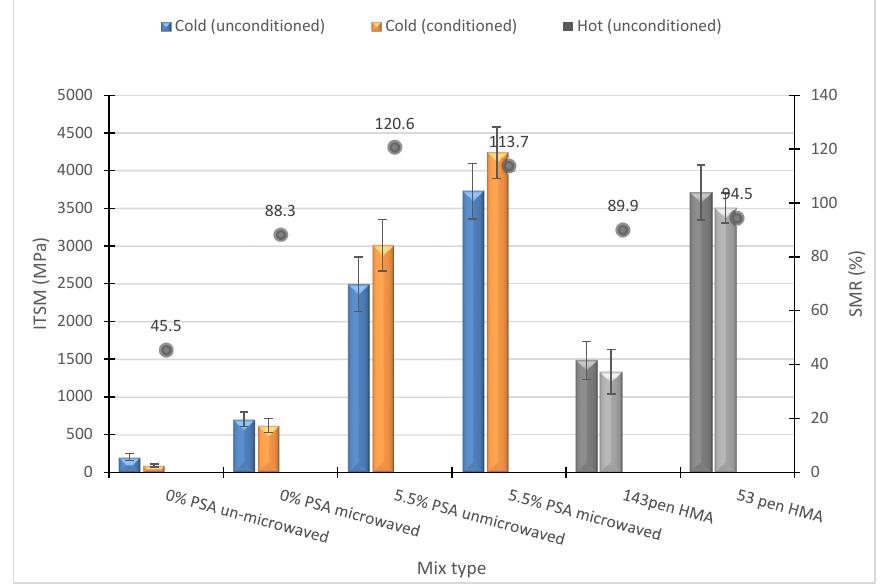
Figure 11. Effect of MW treatment on stiffness modulus ratio.